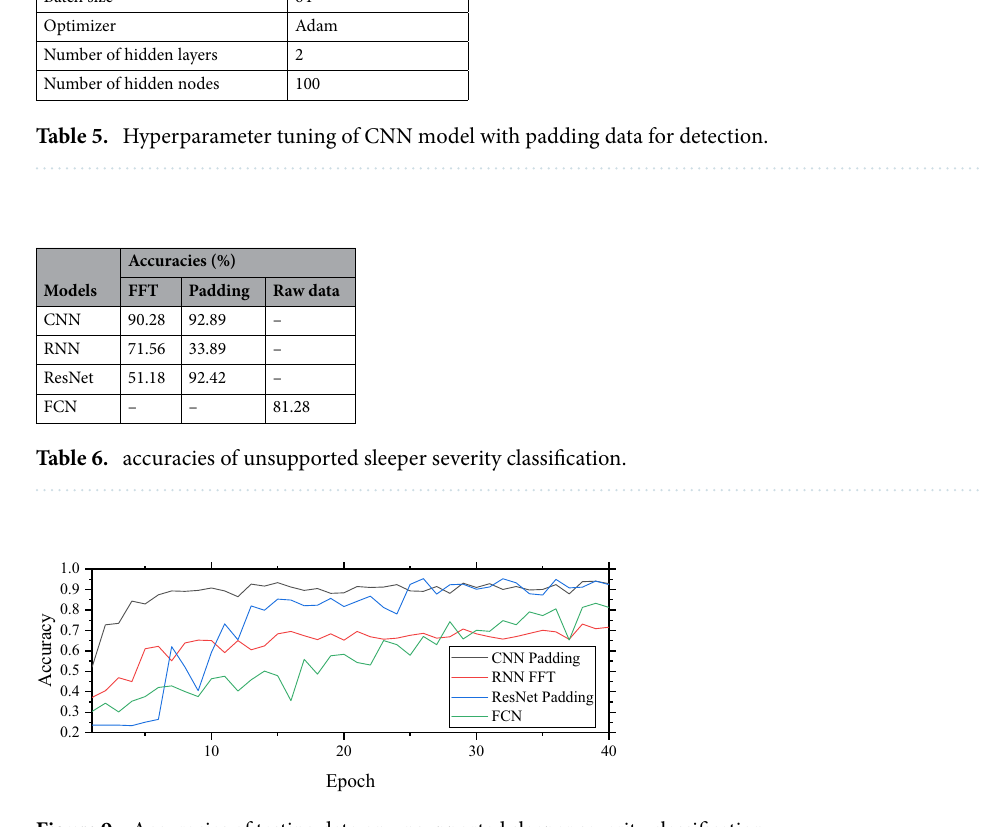
Figure 9. Accuracies of testing data on unsupported sleeper severity classification.